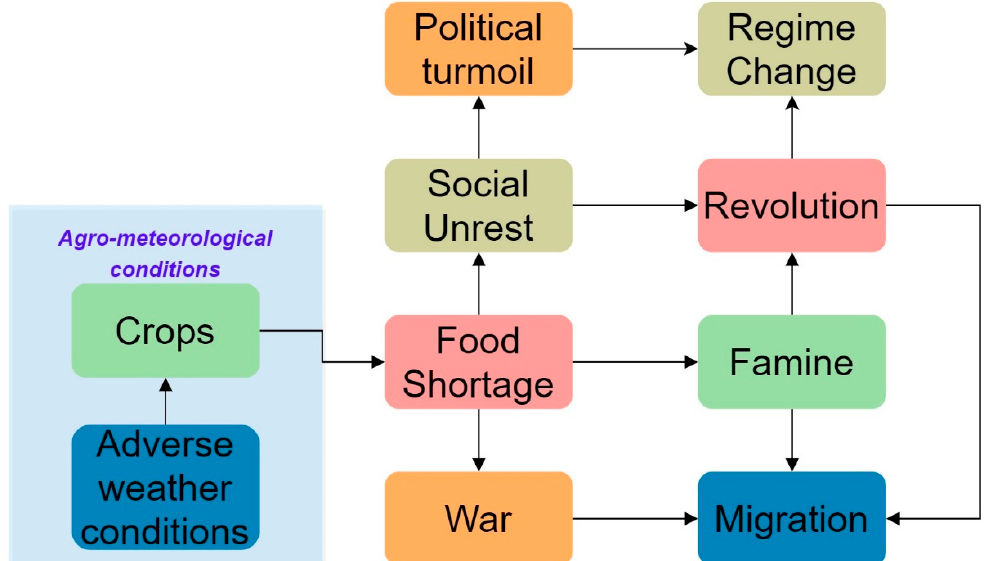
Figure 3. Flowchart of the linkage between agro-meteorological conditions, food shortage, and the consequences of food shortage.